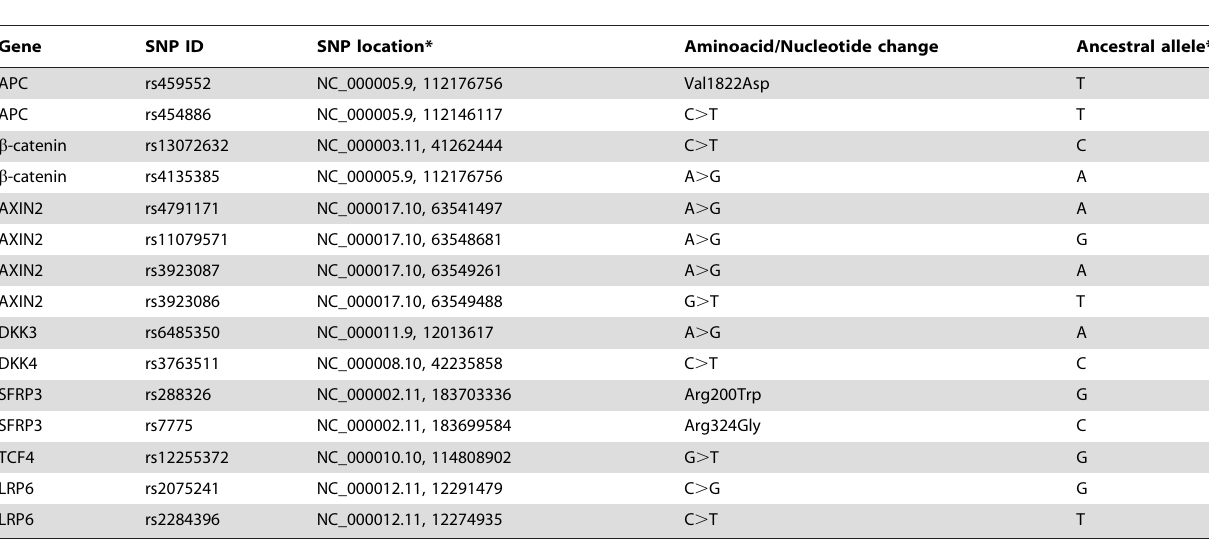
Table 1. Description of SNPs present in Wnt pathway genes that were